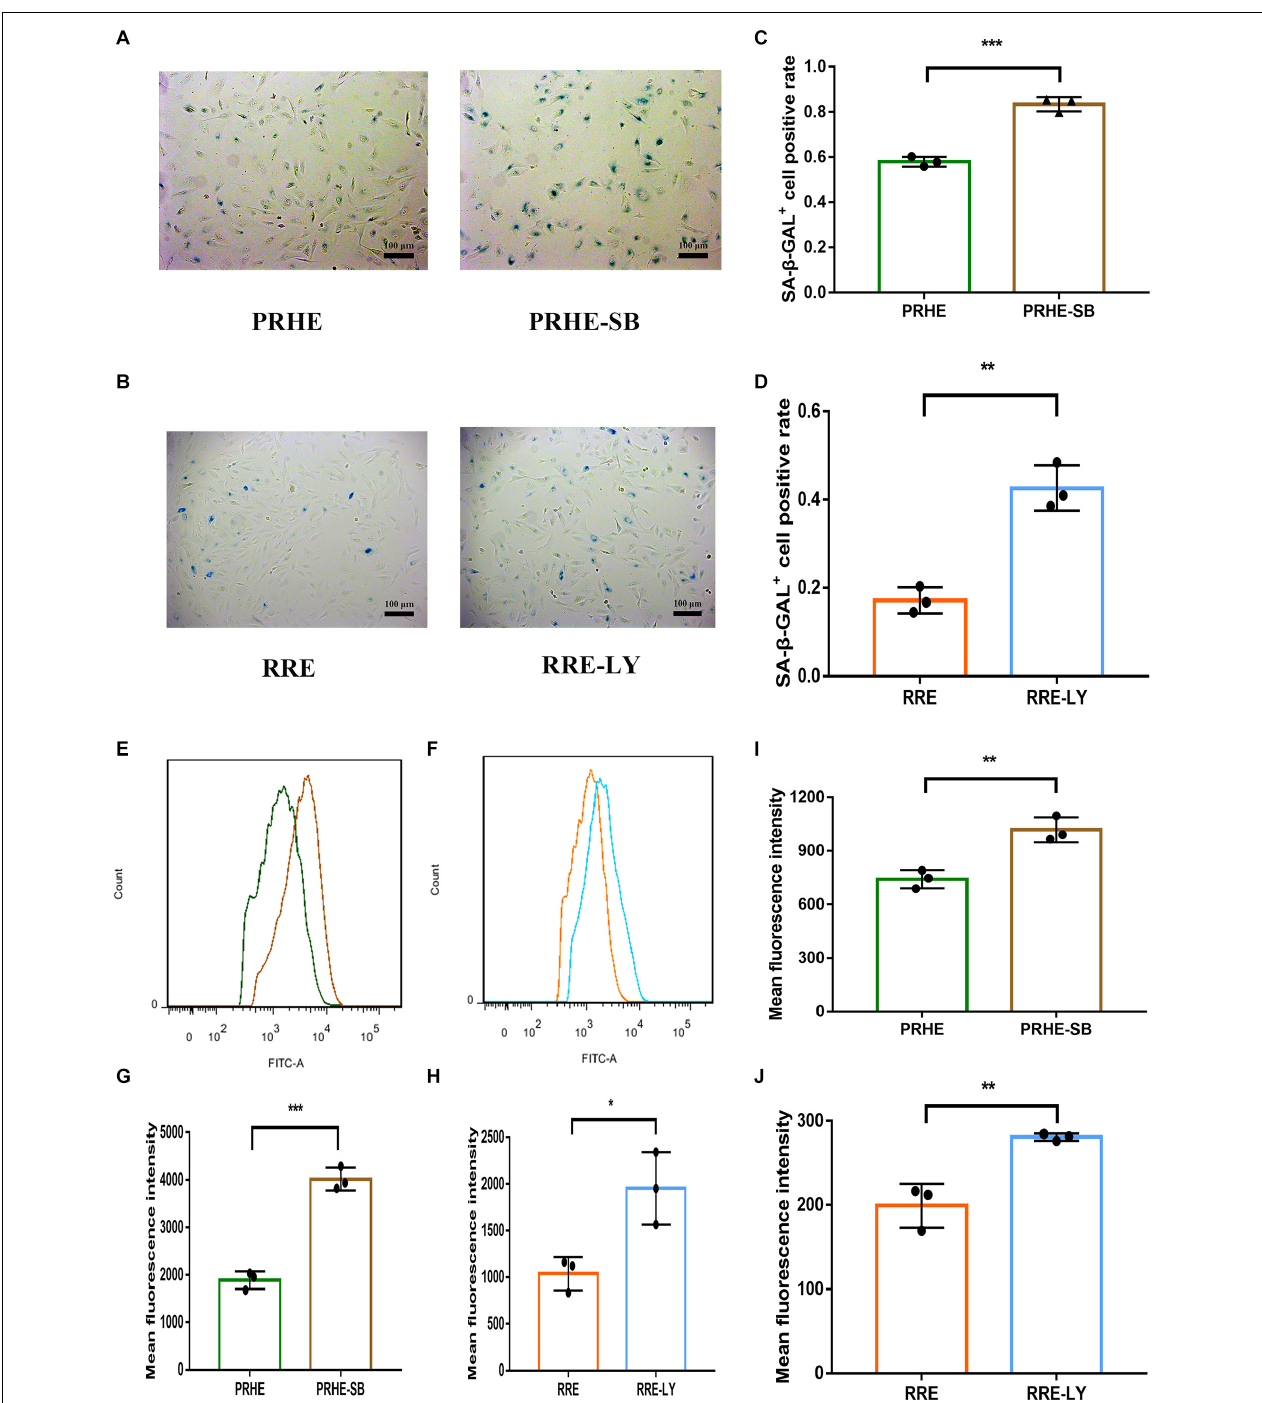
FIGURE 14 | Inhibition of the TGF β and PI3K pathways increased the senescent phenotype of ESCs-cocultured premature and replicative senescent RPE cells. (A) SA- β -GAL activity in the PRHE and PRHE-SB groups, as indicated by phase contrast microscopy. Scale bar, 100 µ m. (B) SA- β -GAL activity in the RRE and RRE-LY groups, as indicated by phase contrast microscopy. Scale bar, 100 µ m. (C,D) Results from the quantification of SA- β -GAL + cells shown in (A,B) , respectively ( n = 3 biological repeats). SA- β -GAL + cells in 4 random fields were scored. The results are expressed as the percentage of stained cells. (E) ROS levels in the PRHE and PRHE-SB groups, as assessed by flow cytometry ( n = 3 biological repeats). (F) ROS levels in the RRE and RRE-LY groups, as assessed by flow cytometry ( n = 3 biological repeats). (G,H) Results from the mean fluorescence intensity shown in (E,F) , respectively. (I) MMP levels in the PRHE and PRHE-SB groups, as assessed by a microplate reader ( n = 3 biological repeats). (J) MMP levels in the RRE and RRE-LY groups, as assessed by a microplate reader ( n = 3 biological repeats). Data are presented as the mean ± SD. ∗ P < 0.05; ∗∗ P < 0.01; ∗∗∗ P < 0.001.